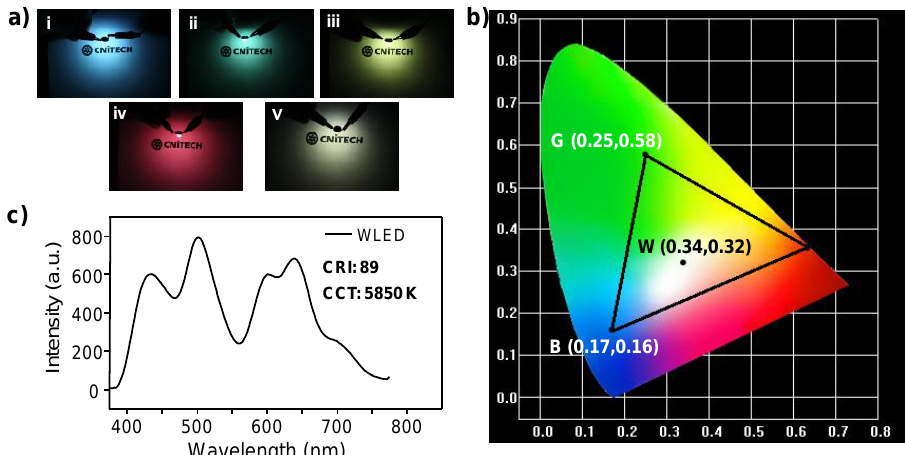
Figure 5. ( a ) Photographs of the monochromic (i – iv) and white (v) LEDs fabricated by encapsulation of b-CDs@ polyvinylpyrrolidone (PVP) (i), g-CDs@PVP (ii), y-CDs@PVP (iii), r-CDs@PVP (iv), and b-, g- and r-CDs@PVP mixtures (v) on UV LED chips (365 nm). ( b ) Commission Internationale de L’Eclairage ( CIE) color coordinates of monochromic red, green, blue, and white LEDs. ( c ) Emission spectra and lighting performance of the white